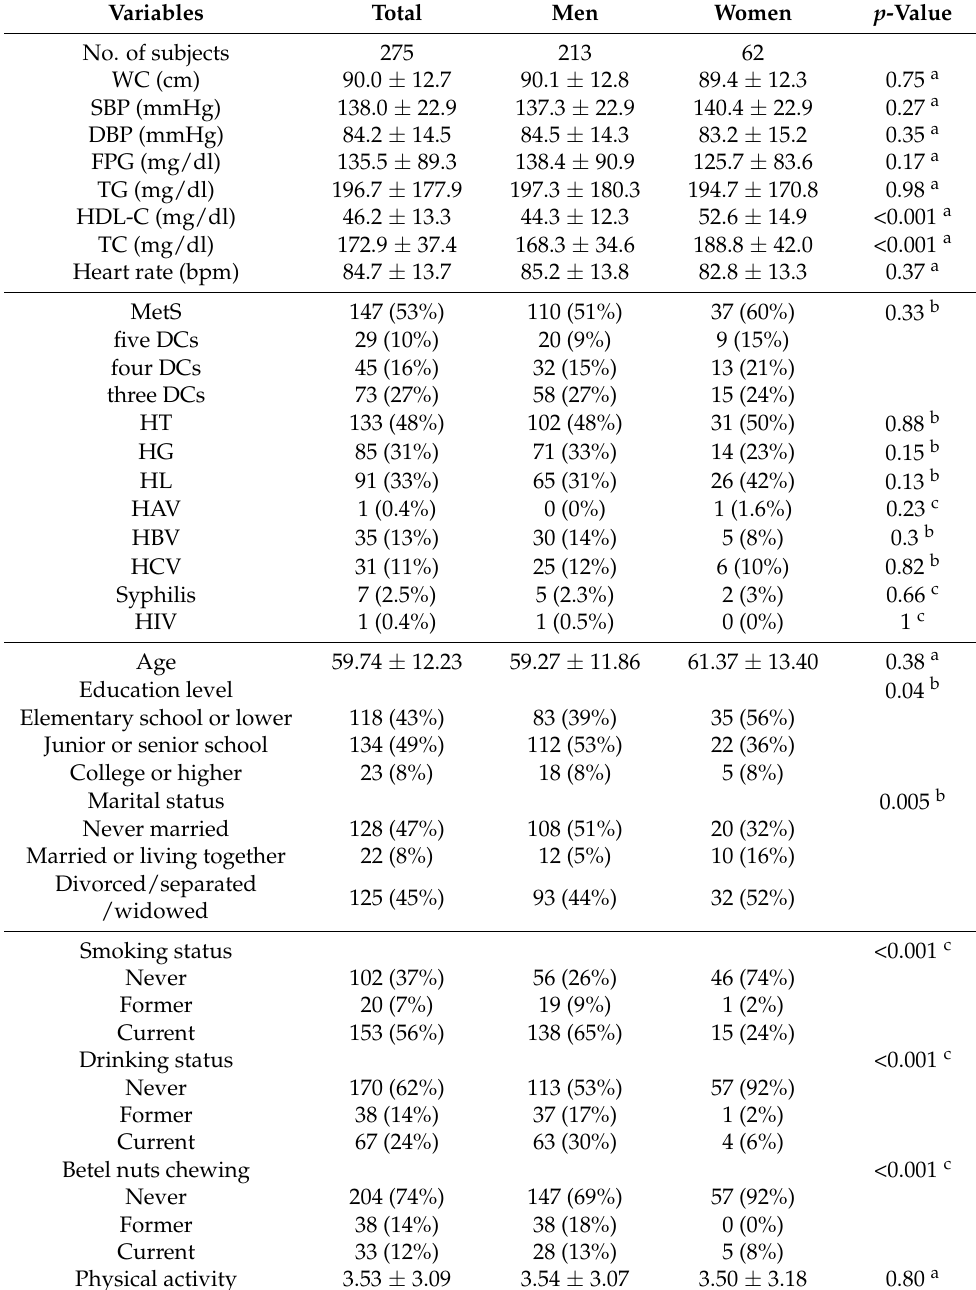
Table 1. Statistical description and analysis of difference under gender